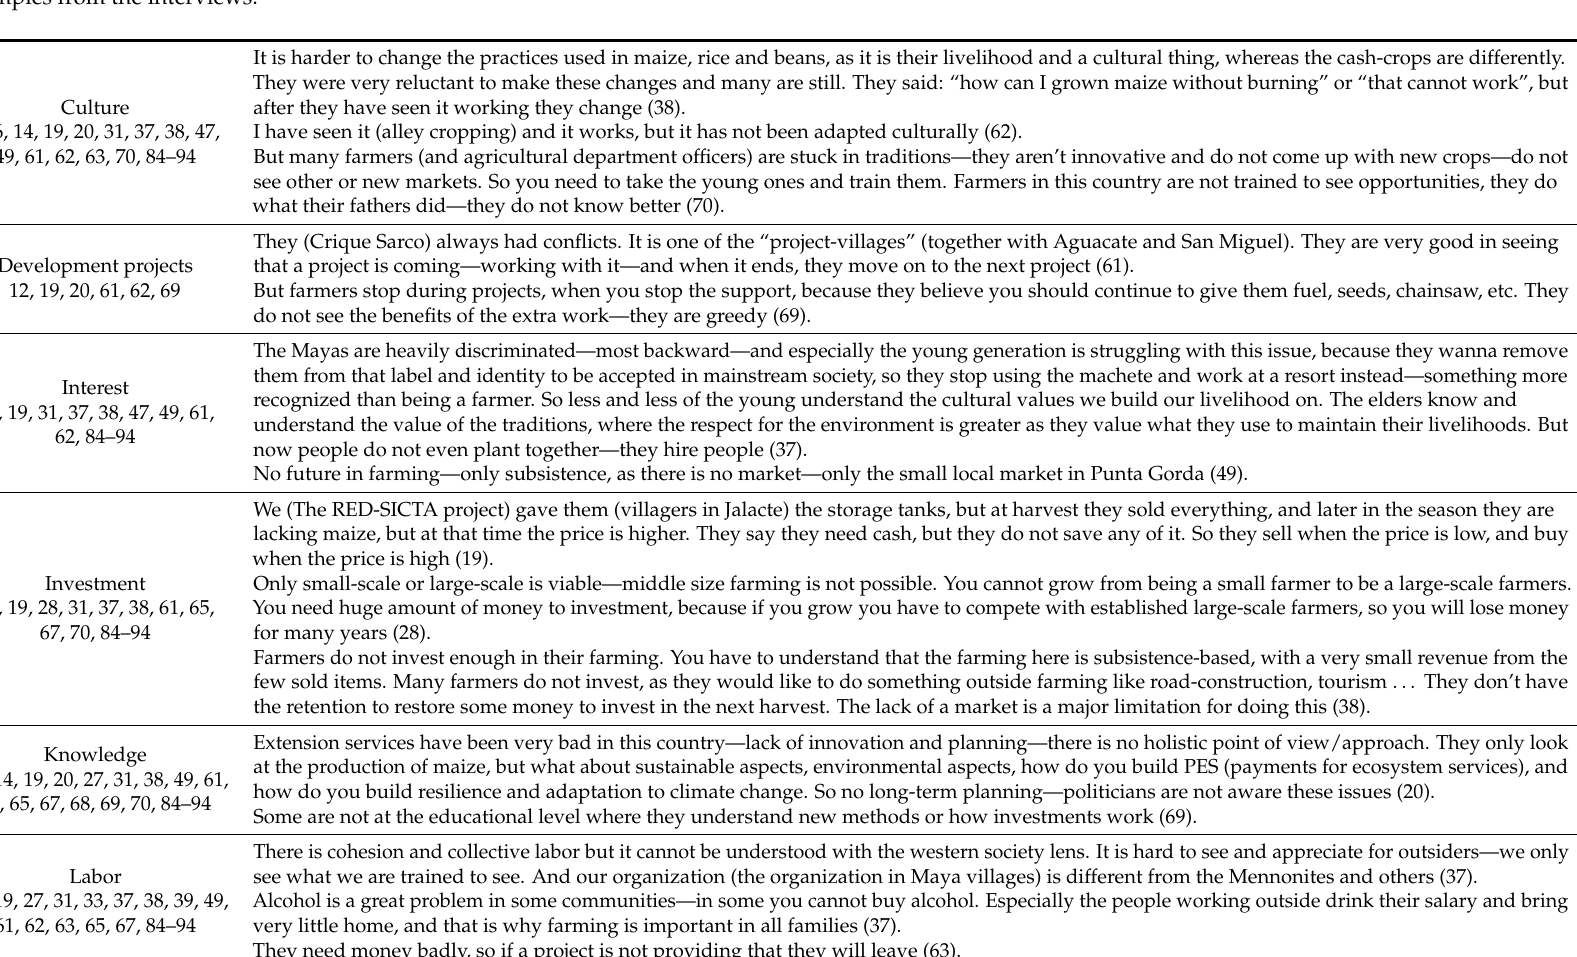
Table 3. Left: The main barriers pointed out by the interviewees of agricultural survey in Belize. Number refers to the interview ID in Table S1. Right: Statement examples from the